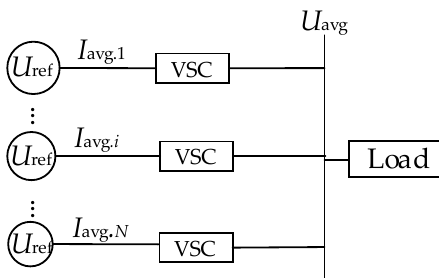
Figure 8. Equivalent model of the DC microgrid current-sharing control.